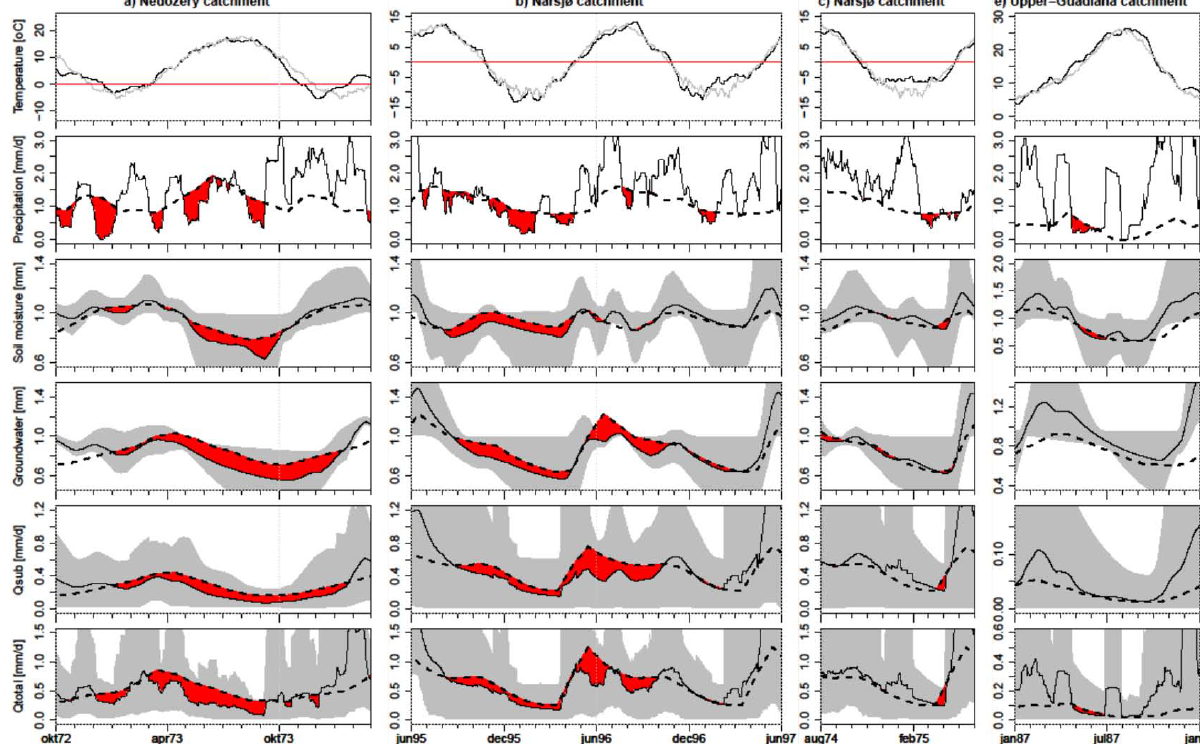
Fig. 5. Examples of difficulties with drought simulation: (a) composite drought in Nedoˇzery (1973), (b) composite drought in Narsjø (1995– 1997), (c) drought in winter in Narsjø (1974–1975), and (d) drought in summer in Upper-Guadiana (1987) (legend: see Fig.